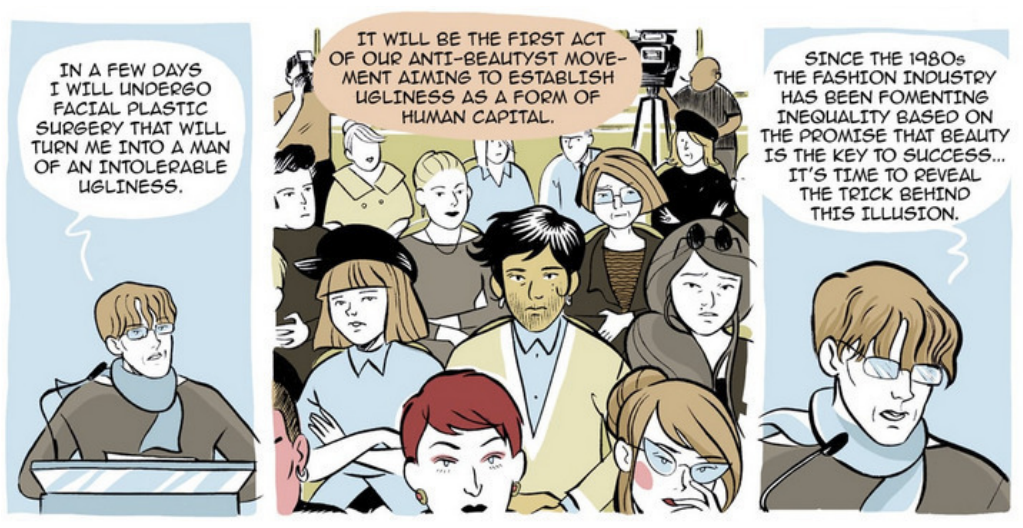
Figure 8: Exposing Beauty